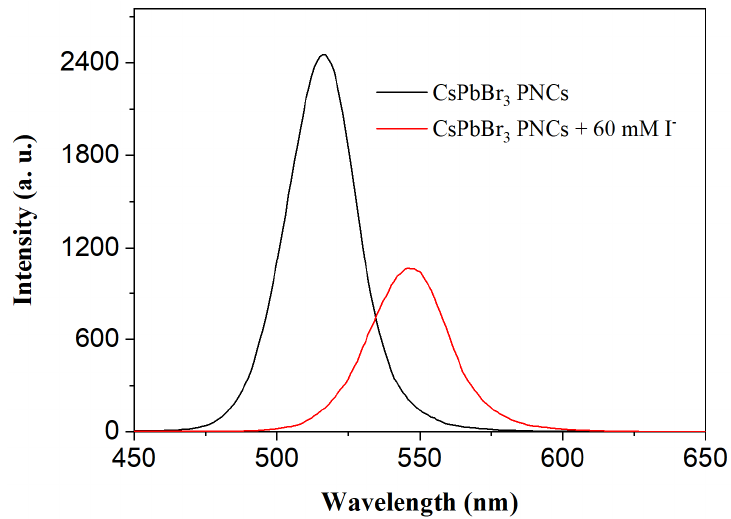
Figure 3. Fluorescence spectra of halide exchanges between CsPbBr 3 PNCs hexane and NaI aqueous solution (60 mmol L − 1 ).